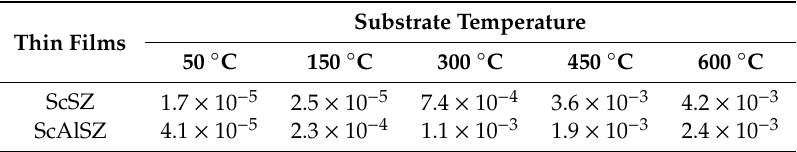
Table 3. Ionic conductivity (S / cm) of ScSZ and ScSZAl thin films deposited using di ff erent substrate temperature and a 0.4 nm / s deposition